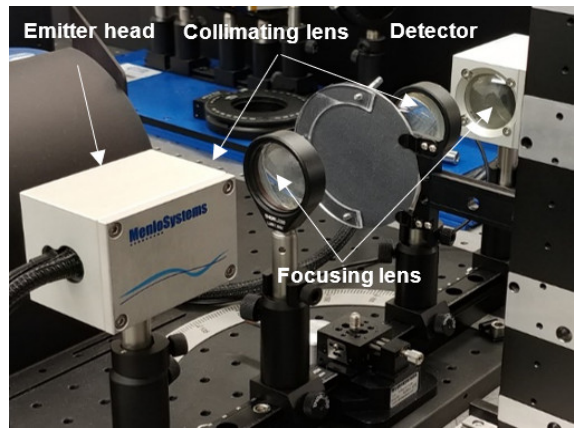
Figure 4. TDS system measurement set up.